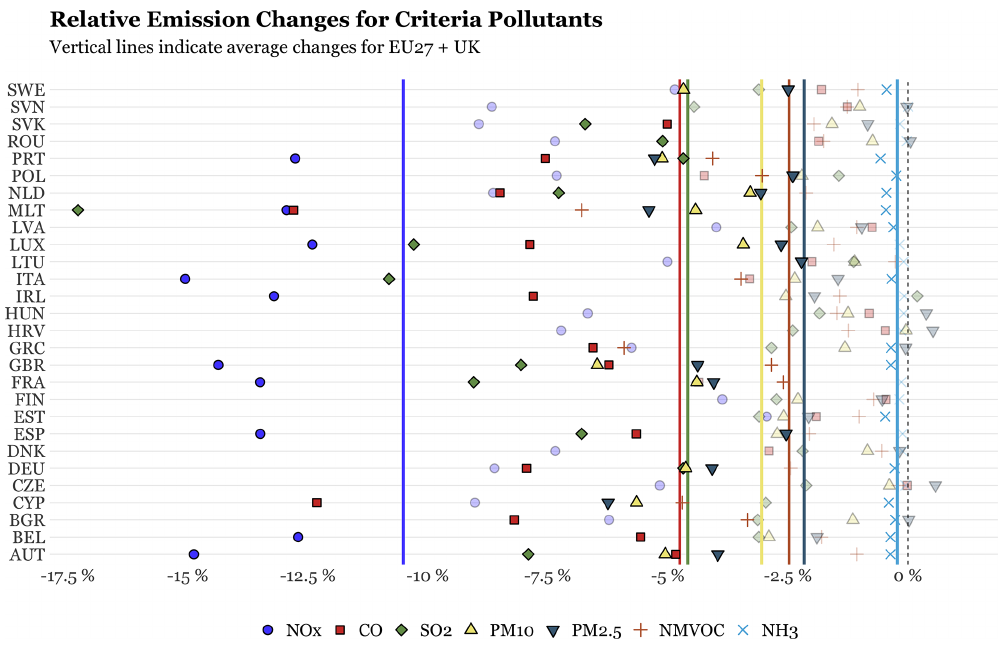
Figure 6. Relative decline in emissions of criteria pollutants [%] per species and country in 2020. The vertical lines indicate the average relative declines at the EU27 + UK level. Non-shaded marks highlight those countries/species for which reductions are larger than the ones computed at the EU27 + UK level.